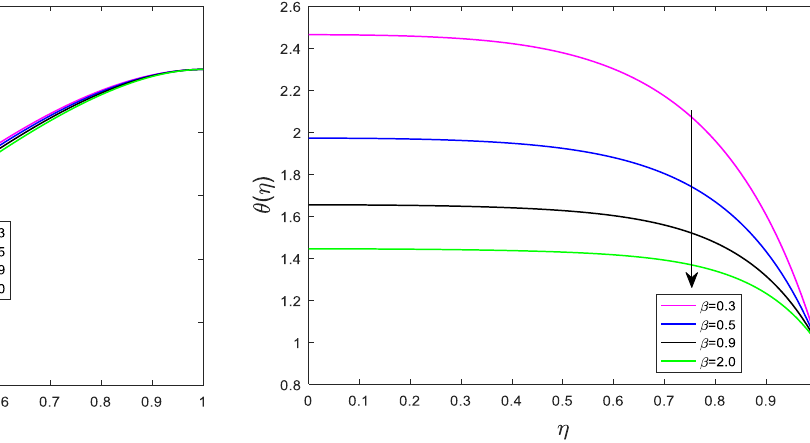
Figure 8: Effect of β on θ ( η ) for fixed S = 6.0, Ha = Ω C = N t = Kr = 0.1, Ω = Ec = 0.5, N = 0.3, Pr = 1.5 and Sc = 0.7 b T